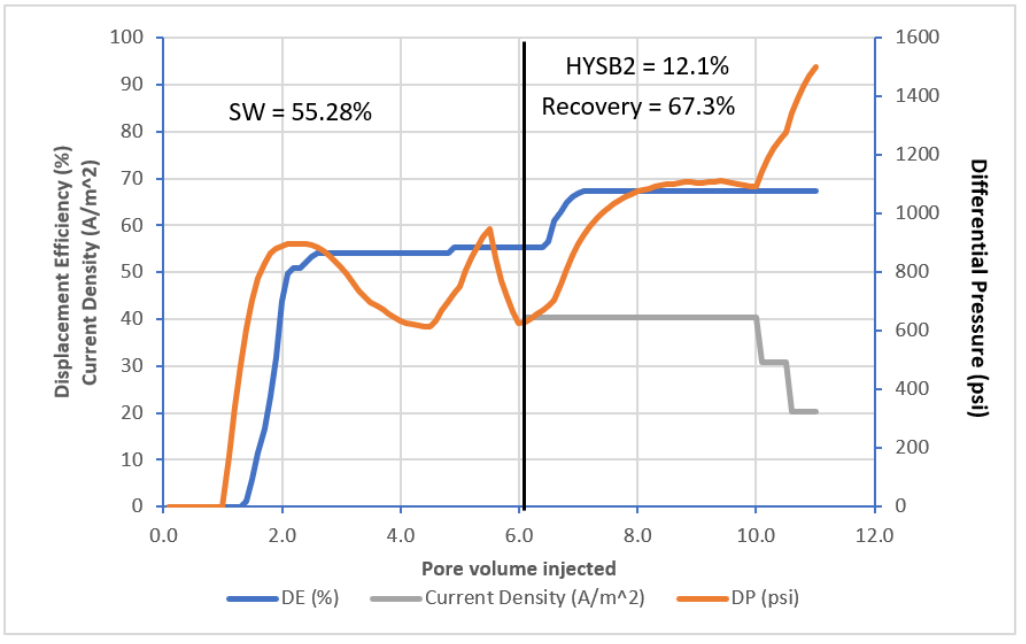
Figure 12. DE, DP ( ∆ P), Current Density vs. Pore Volume Injected for CF10. Figure 12. DE, DP (ΔP), Current Density vs. Pore Volume Injected for CF10 . CF11 CF11